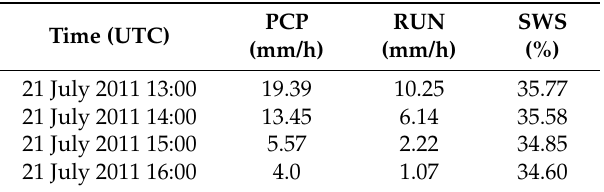
Table 3. Basin mean for rainfall (PCP), overland flow (RUN), and soil water in root zone (SWS) in sub-basin No. 31 for the flood event on 21 July